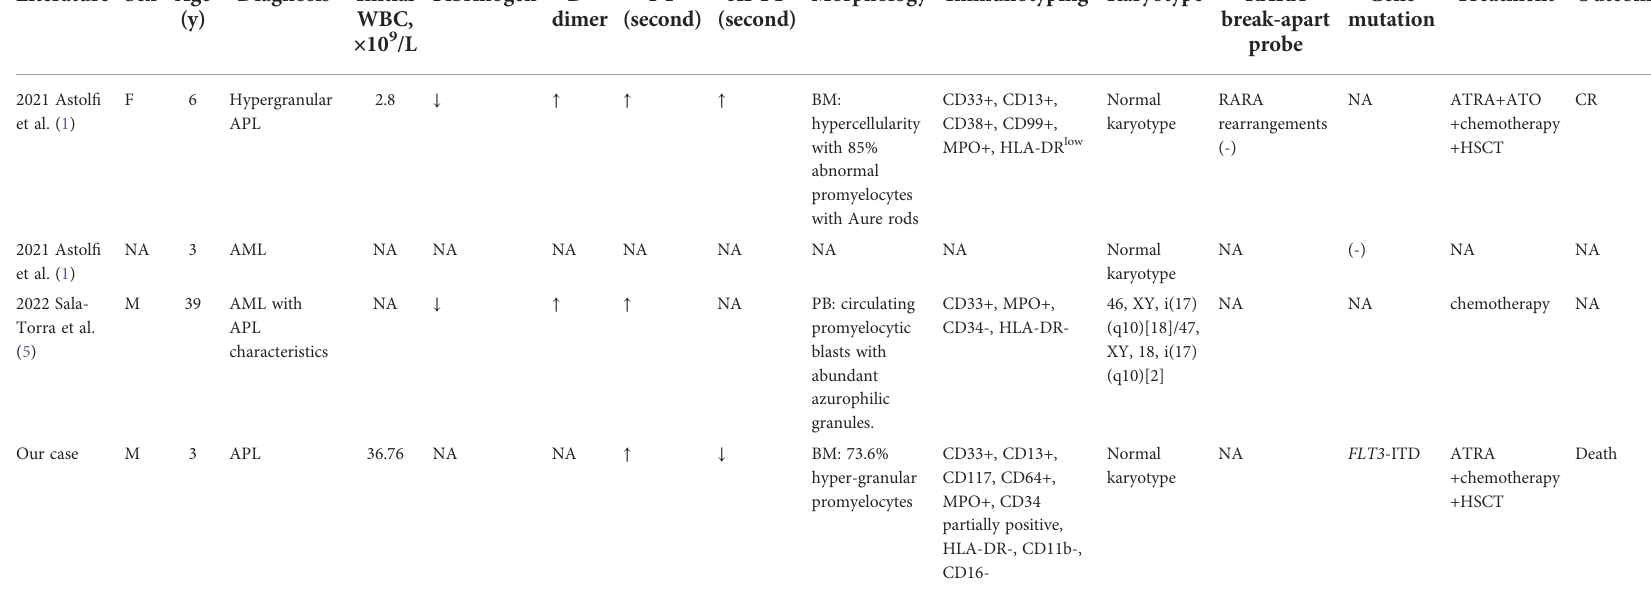
TABLE 1 Summary of clinical and laboratory characteristics in the 4 reported cases with TTMV :: RARA